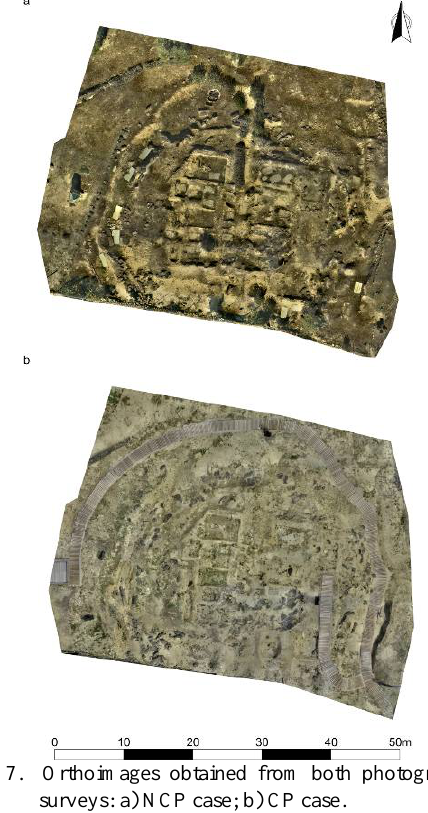
Figure 7. Orthoimages obtained from both photogrammetric surveys: a) NCP case; b) CP case.